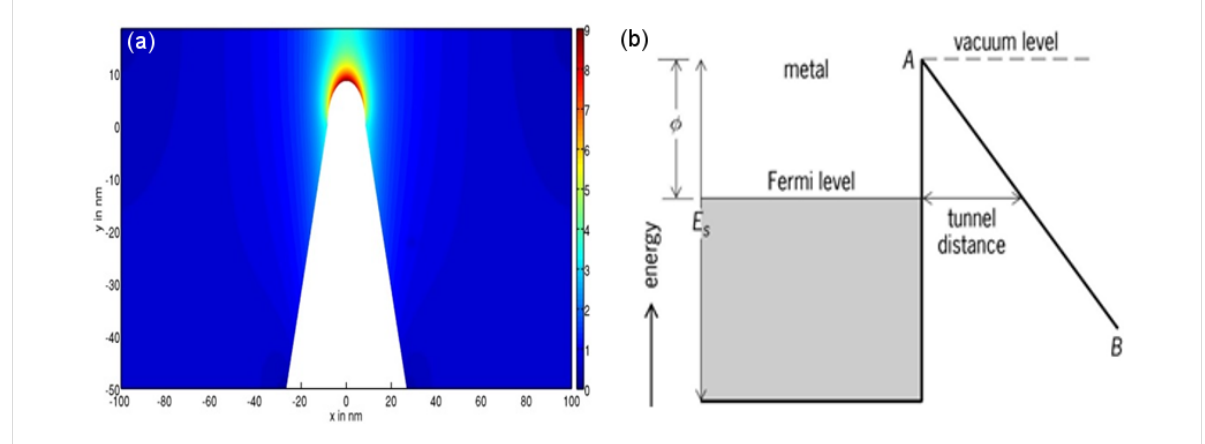
Figure 14: (a) Thermographic scale representation of the electric field between tip and sample calculated by solving the Laplace equation for a voltage of 50 V, a tip–sample distance of 10 nm and a tip diameter of 17 nm. (b) Schematic description of the fundamentals of electron tunneling into air from the tip of a scanning